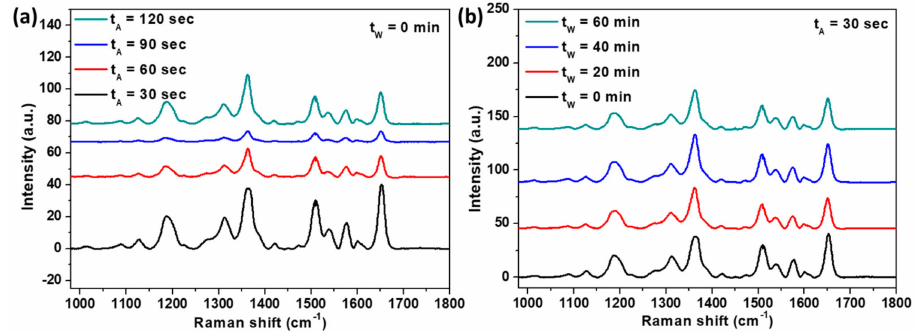
Figure 9. SERS spectra with R6G dye molecules as a function of ( a ) anodization time and ( b ) pore widening time. ( a ) QU-AAO templates with the widening time of 0 min are used; ( b ) QU-AAO templates with an anodization time of 30 s are used. The concentration of R6G was 100 µ